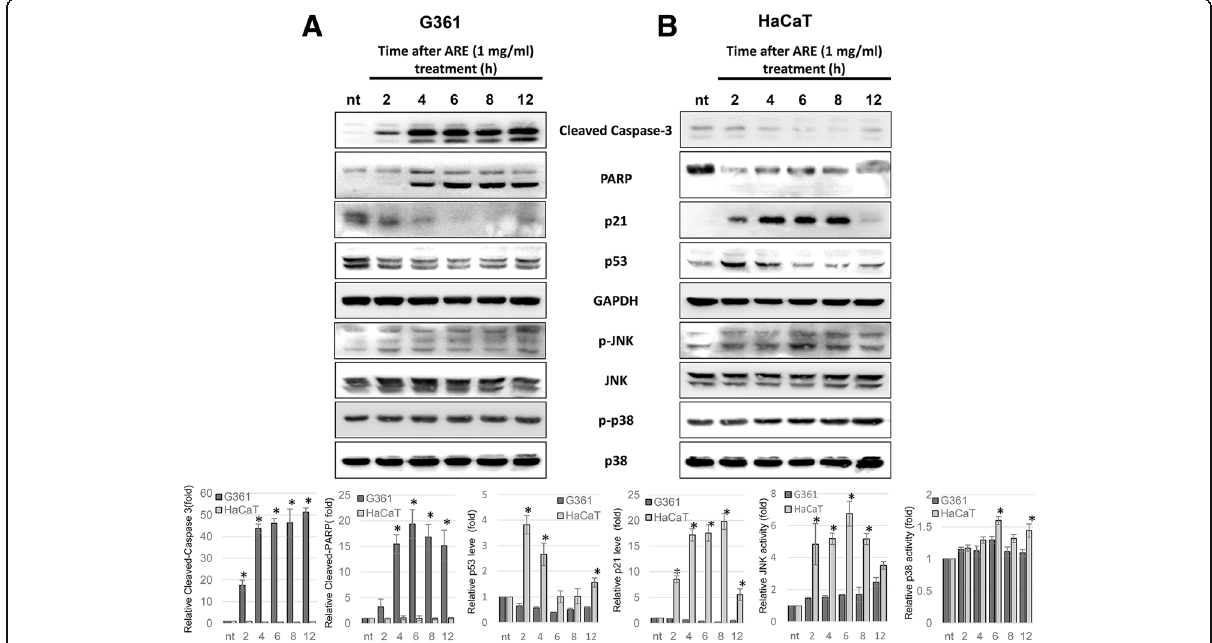
Fig. 4 Time-dependent effects of ARE on the expression of apoptosis- and stress-related proteins in G361 and HaCaT cells. The results of western blot analysis in G361 ( a ) and HaCaT ( b ) cells treated with 1 mg/ml of ARE for 2, 4, 6, 8, and 12 h are shown. The relative density of each proteins of ( a ) and ( b ) were represented as graphs (bottom panel). Data represent the mean ± SEM ( n = 3). The significant difference between HaCaT and G361 cells were marked as * ( p <